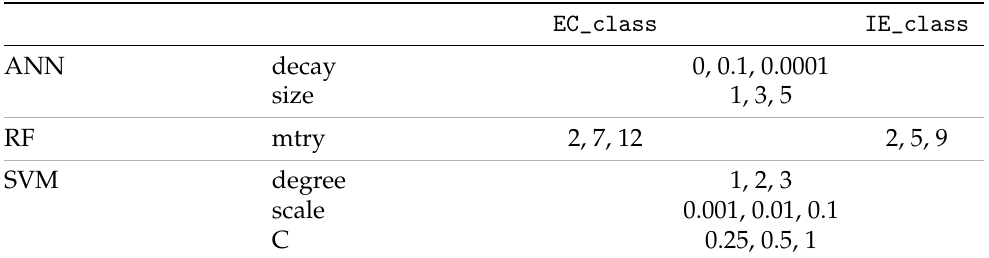
Table 4. Tuning parameters for ANN, RF, and SVM for EC_class and IE_class .